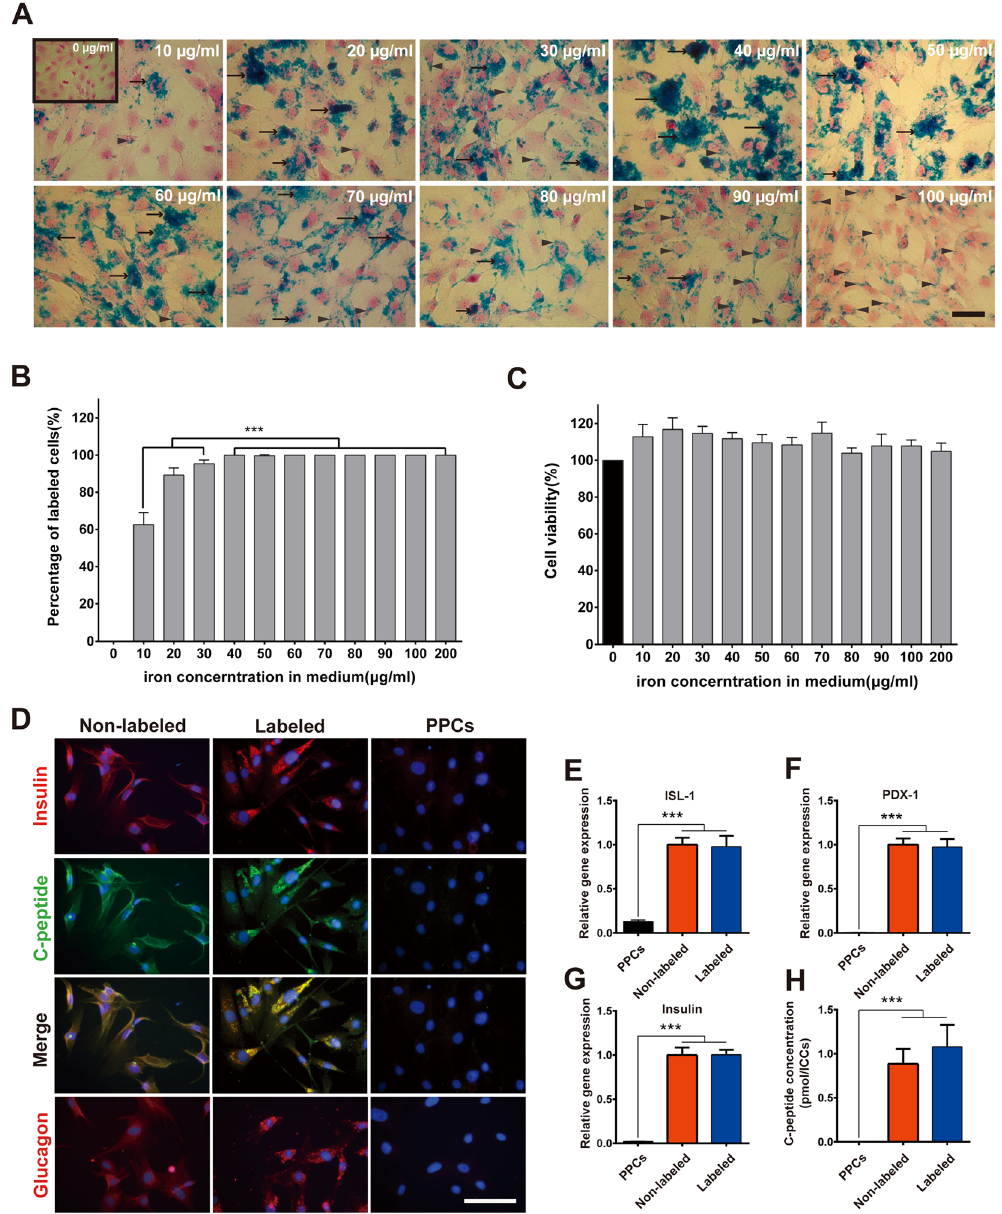
Figure 2. ( A ) Light micrographs showing the effect of SPION concentration on the uptake of iron oxide nanoparticles in cultured PPCs by Prussian blue staining. Few Prussian-blue positive cells were detected in the 10 μ g Fe/ml SPIONs group, and more positive cells were present in the groups treated with concentrations of SPIONs of more than 20 μ g Fe/ml. However, numerous Feridex-PLL complexes deposited on the cellular surface were observed in groups treated with 20 to 70 μ g Fe/ml (arrows indicate Feridex-PLL complexes on the cellular surface). The deposition of complexes on the cellular surface was significantly decreased in groups treated with more than 80 μ g Fe/ml SPIONs, and most of the Feridex-PLL complexes were phagocytized into the cytoplasm (arrowheads indicate Feridex-PLL complexes inside cells). These results suggested that 100 μ g Fe/ml of SPIONs was an optimal concentration. ( B and C ) Bar graphs showing the effect of SPION concentration on the labeling efficiency and cell viability. The results are shown as the mean ± SD, n = 8 (independent experiments); *** P < 0.001. ( D ) In the final stage of differentiation, non-labeled and labeled cells showed expression of insulin (red fluorescence), C-peptide (green fluorescence), glucagon (red fluorescence), and colocalized insulin/C- peptide (orange fluorescence). PPCs were used as a negative control. Real-time PCR analysis of β -cell-specific genes: ( E ) Isl-1, (F) PDX-1, and ( G ) insulin expression in PPCs and non-labeled, and labeled ICCs. ( H ) ELISA measurements of the C-peptide content in PPCs and non-labeled, and labeled ICCs. The results shown are the mean ± SD, n = 4 (independent experiments); *** P < 0.001. Scale bars represent 100 μ